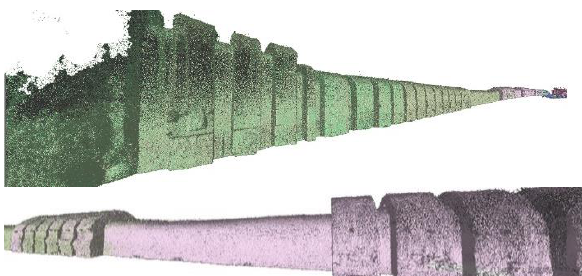
Figure 6: The entire point cloud of the tunnel after merging the various